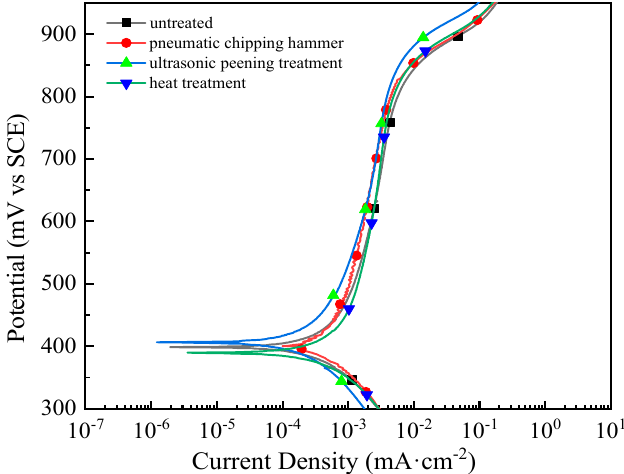
Figure 15. Polarization curve of the welded joints with different treatments methods: 1—untreated; 2—pneumatic chipping hammer; 3—ultrasonic peening treatment; 4—heat treatment. Table 2. Experimental results of electrochemistry of welded joint with different treatments. Processing